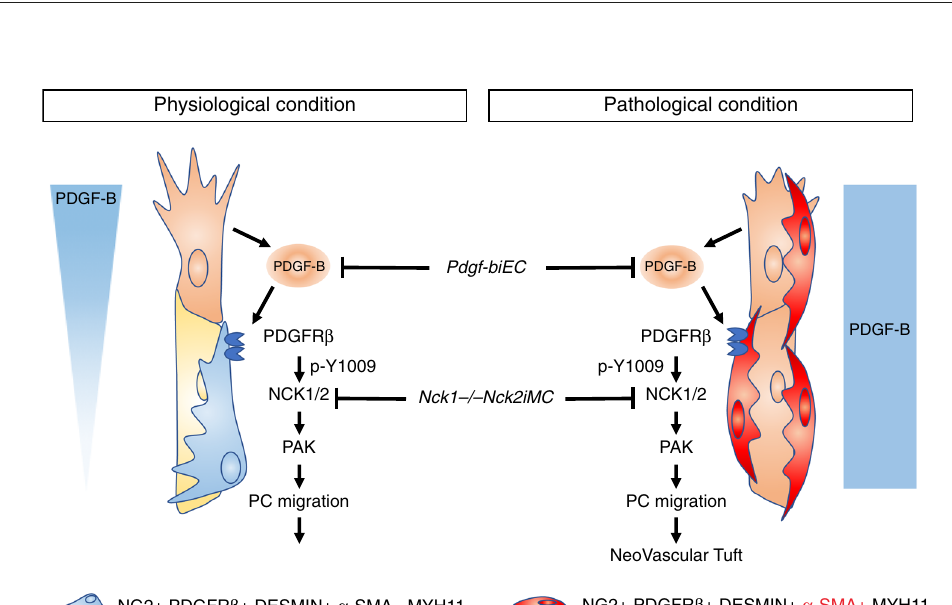
Fig. 8 Pericyte Nck1 / 2 deletion improves OIR revascularization. a Strategy to assess neoangiogenesis after OIR. Nck2 deletion is induced at P12, P13, and P14. b Flat mounts of P17 Nck1 − / − Nck2iMC and littermate control OIR retinas. Insets show avascular area measured for quanti fi cation. Lower panels show higher- magni fi cation images of pathological vascular tufts. c Avascular area (top) and NVT (bottom) quanti fi cation. Number of retinas used for quanti fi cation is indicated. Error bars represent s.e.m. ⋆⋆⋆ P <0.001, Mann – Whitney U test. d (Left) Quanti fi cation of α -SMA (top) and PDGFR β (bottom) coverage of IB4 + vascular tufts. Number of retinas used for quanti fi cation is indicated. Error bars represent s.e.m. NS: non-signi fi cant. ⋆ P < 0.05, Mann – Whitney U test. (Right) IB4, PDGFR β , and α -SMA triple staining of the NVTs. Note the smaller and sometimes α -SMA-negative tufts in Nck1 − / − Nck2iMC double-mutant mice (arrows). e (Left) Quanti fi cation of DESMIN coverage of IB4 + vascular sprouts in P17 OIR retinas ( n = 9 imaging fi elds for Nck1 − / − Nck2l/l from 6 retinas and n = 12 for Nck1 − / − Nck2iMC from 6 retinas). (Right) IB4 and DESMIN double staining of the angiogenic sprouts. Error bars represent s.e.m. ⋆⋆⋆ P <0.001, Mann – Whitney U test. f Quanti fi cation of α -SMA coverage of IB4 + vascular sprouts in P17 OIR retinas ( n = 10 imaging fi elds for Nck1 − / − Nck2l/l from 2 retinas and n = 23 for Nck1-/-Nck2iMC from 4 retinas). Error bars represent s.e.m. ⋆⋆⋆ P < 0.001, Mann – Whitney U test. g , h Images ( g ) and quanti fi cation ( h ) of FIBRINOGEN leakage in Nck1 − / − Nck2iMC compared to control littermate mice. Number of mice used for quanti fi cation is indicated. Error bars represent s.